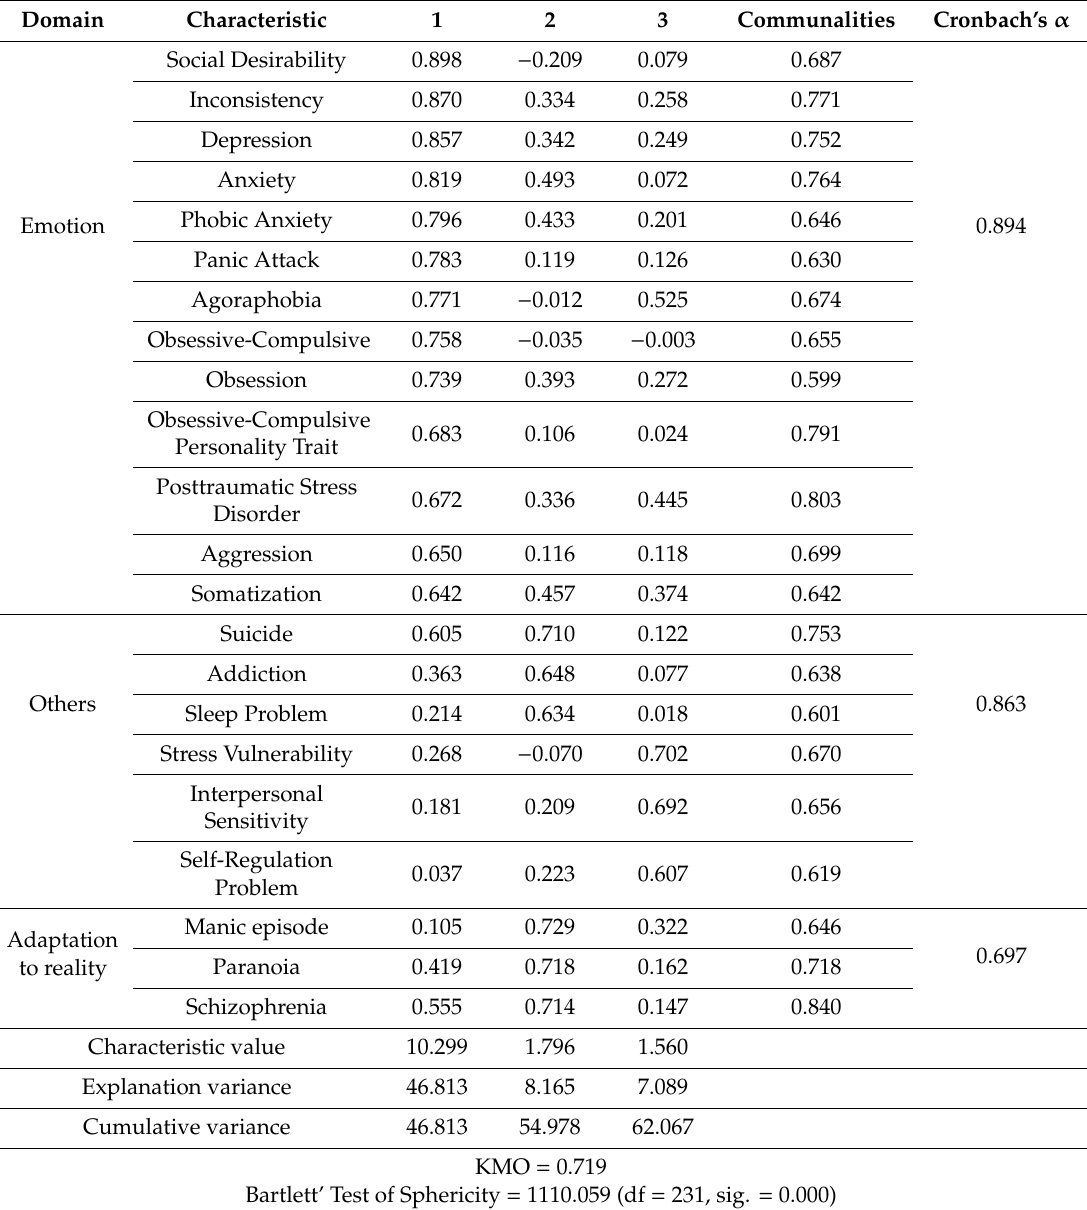
Table 2. Validity and reliability of mental health